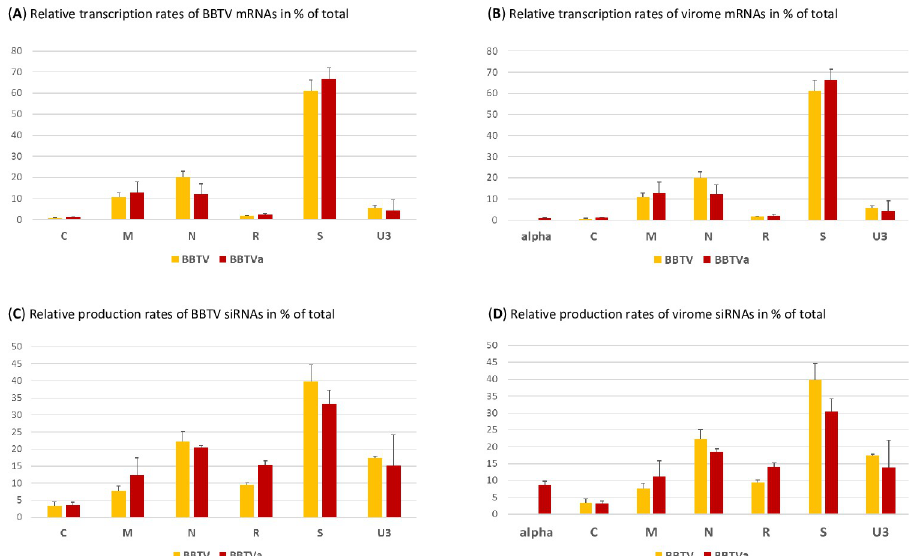
Fig 8. Impact of alphasatellite on relative transcription rates of viral mRNAs and relative production rates of viral siRNAs. Transcription rates of viral mRNAs were calculated by dividing mRNA counts in reads per million by viral DNA loads (measured by qPCR) and by mRNA unit sizes in nucleotides (alphasatellite = 902 nts; C = 549 nts; M = 526 nts; N = 511 nts; R = 883 nts; S = 603 nts; U3 = 231 nts) and the relative transcription rates of viral genome components in the presence (red) and absence (yellow) of alphasatellite (alpha) was plotted in percentage (%) of total BBTV ( A ) and virome ( B ) transcription rates. Production rates of viral 19–25 nt sRNAs were calculated by dividing sRNA counts in reads per million (RPM) by viral DNA loads (measured by qPCR) and the relative sRNA production rates from viral genome components in the presence (red) and absence (yellow) of alphasatellite (alpha) were plotted in % of total BBTV ( C ) and virome ( D ) production rates. Error bars represent standard deviations for three biological replicates.